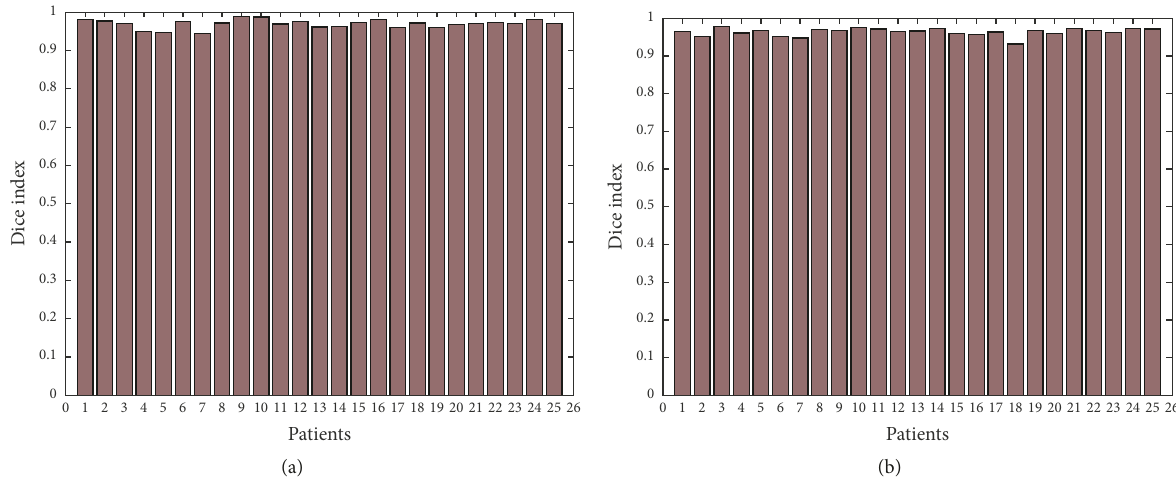
Figure 14: Dice index in thermal images for 50 patients; (a) 25 with high-grade taken from BRATS 2012; (b) 25 with low-grade taken from BRATS 2013.